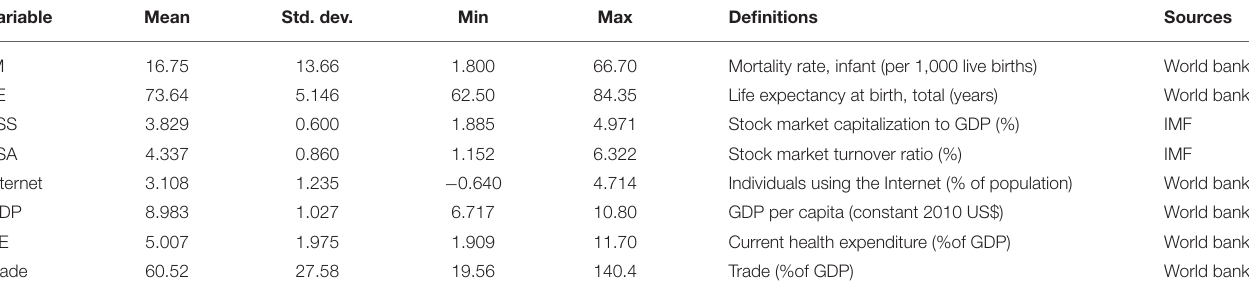
TABLE 1 | Data descriptions and